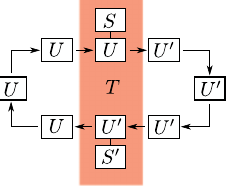
FIG. 9. Sketch of the setup to demonstrate the Kelvin-Planck statement of the second law: The outgoing units U 0 after the interaction with system S are reset to the state U via interaction with a second system S 0 coupled to the same thermal reservoir as S